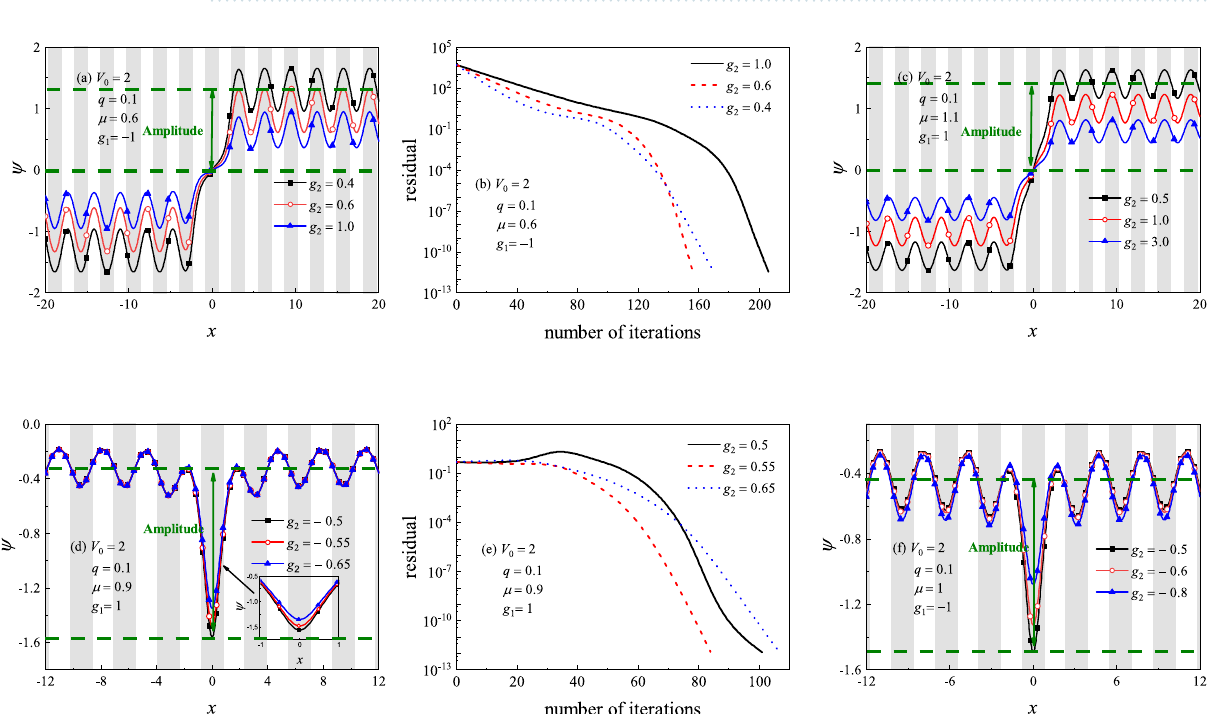
Figure 2. Amplitude of on-site gap solitons versus the three-body interaction strength g 2 . ( a ) In the semi- infinite gap. ( b ) In the first gap.